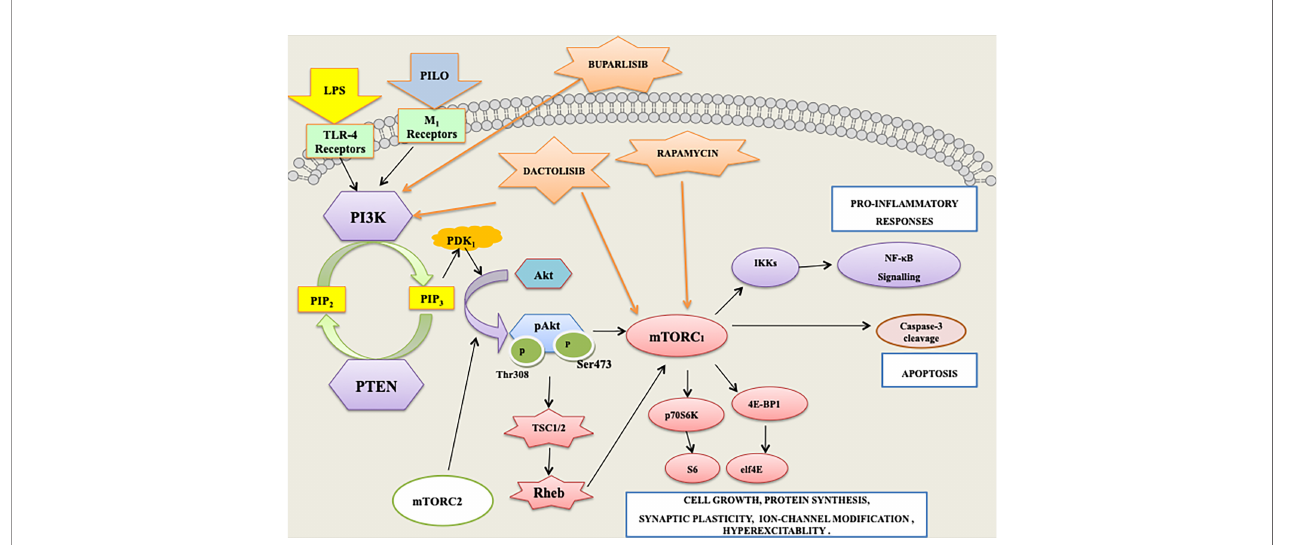
FIGURE 13 | PI3K/AKT/mTOR/p70S6K signaling mediates the apoptotic and in fl ammatory responses associated with lipopolysaccharide (LPS) and pilocarpine (PILO) induced